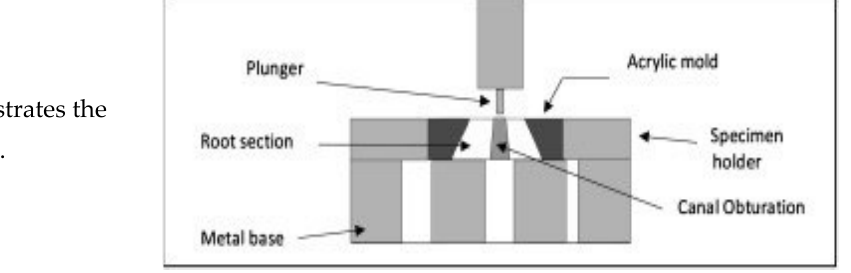
Figure (1) : Schematic illustrates the push-out